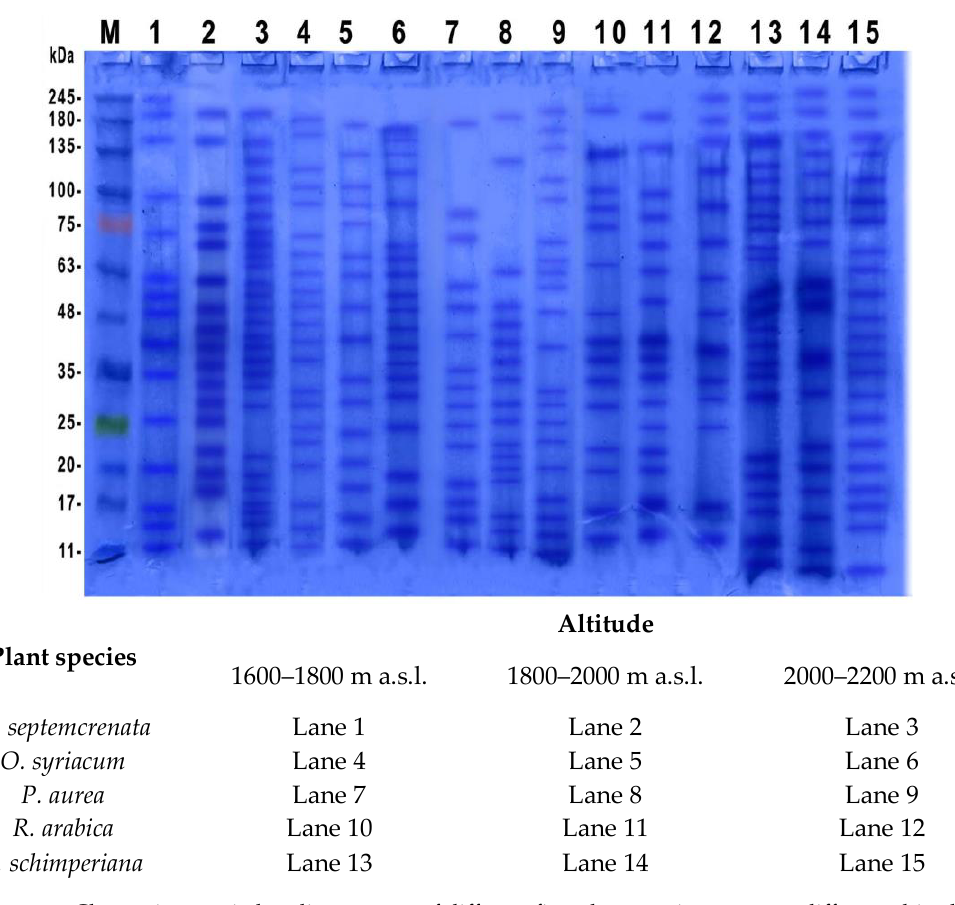
Figure 5. Change in protein banding pattern of different five plant species grown at different altitudes of SKP mountains.